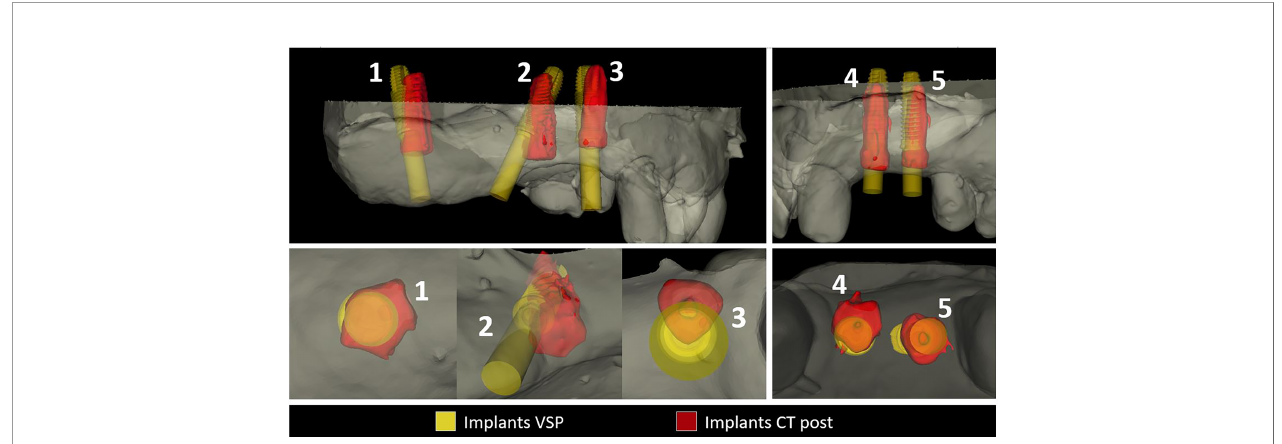
FIGURE 8 | Virtual surgical planning in yellow comparison with fi nal intraoperative position. Excellent accuracy in implants 1,2,4,5, mismatch error in implant 2. Implant 2 while inserting into an extremely narrow alveolar bone developed a vestibular complete fenestration. We intraoperatively corrected the position freehand seeking adequate bone volume. Since this implant is not guided, we withdrew the fi nal result from our study.